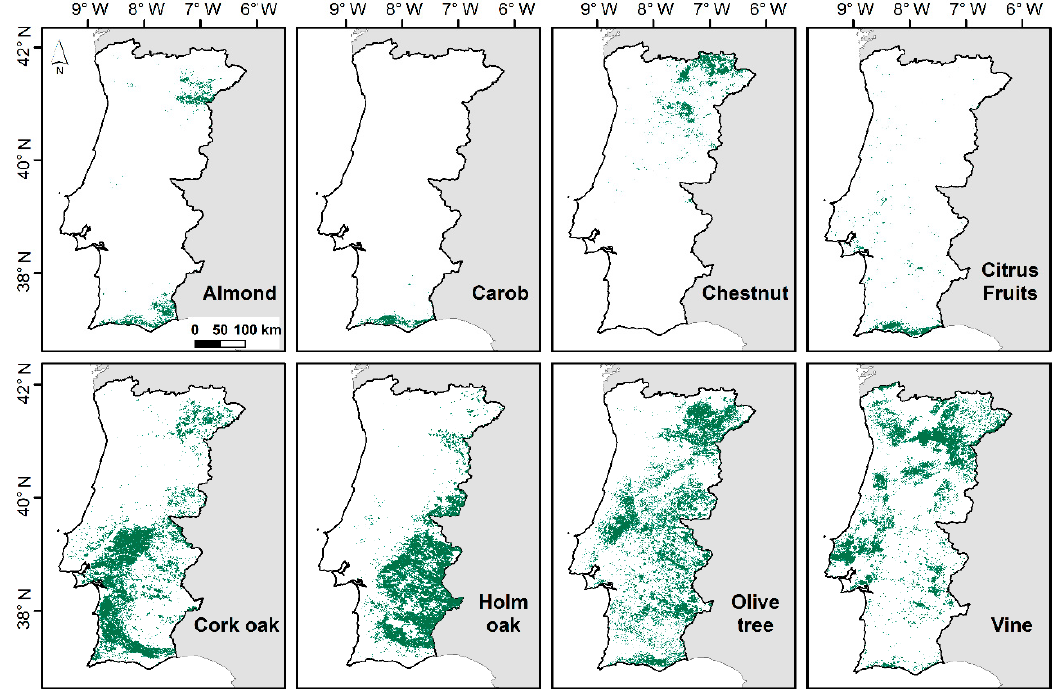
Figure 6. Spatial distributions of the eight outlined species over mainland Portugal (Source: COS 2007).